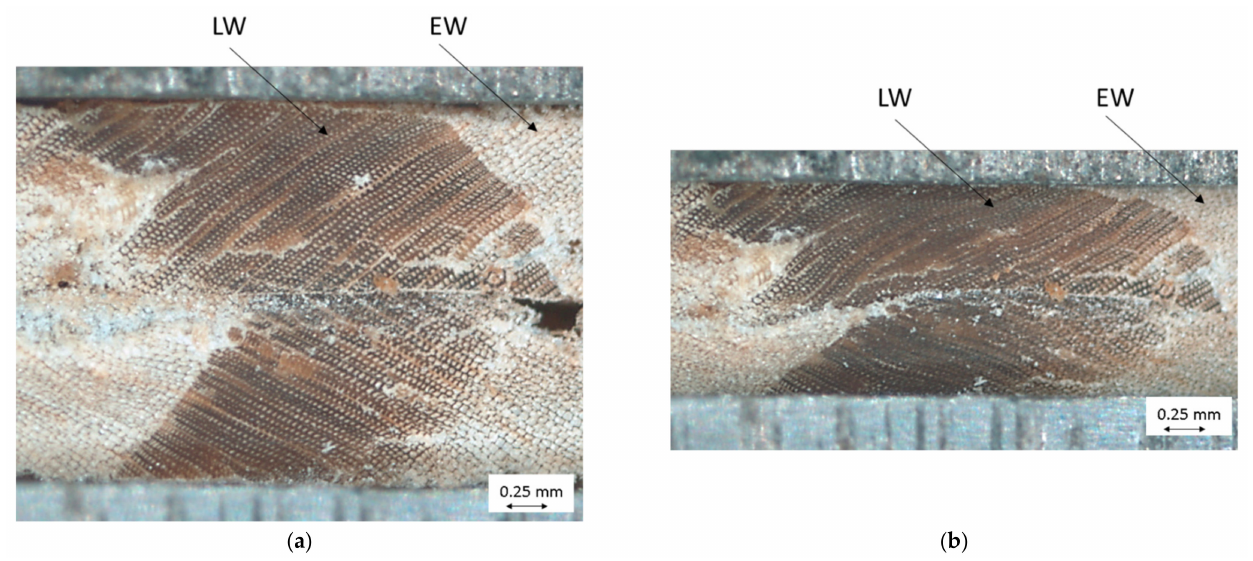
Figure 15. Compression of two layered wood particles with two stacked LW areas—initial state ( a ), deformed state ( b